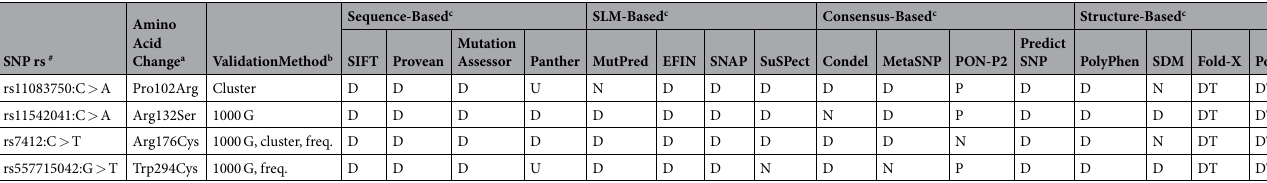
Table 1. Results of APOE convergent deleterious predicted SNPs analyzed by 16 prediction tools classified in four different groups. a APOE amino acid positions is relative to GenBank Accession number NP_000032.1. b 1000G: SNP has been sequenced in the 1000 Genomes Project; freq.: Validated by frequency or genotype data: minor alleles observed in at least two chromosomes; cluster: Validated by multiple, independent submissions to the refSNP cluster. c N: Neutral; D: Deleterious; ST: Stabilizing; DT: Destabilizing; P: Pathogenic; U: Unknown.